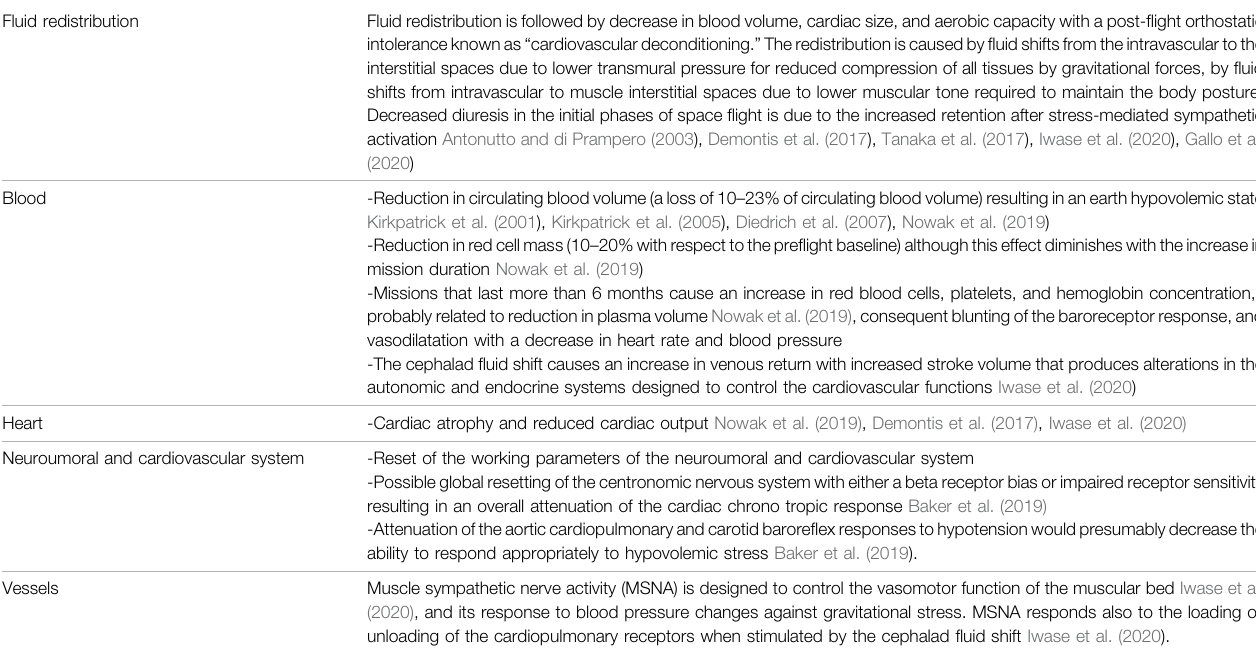
TABLE 1 | Effects of microgravity that could affect physiologic response to hemorrhage. Fluid redistribution